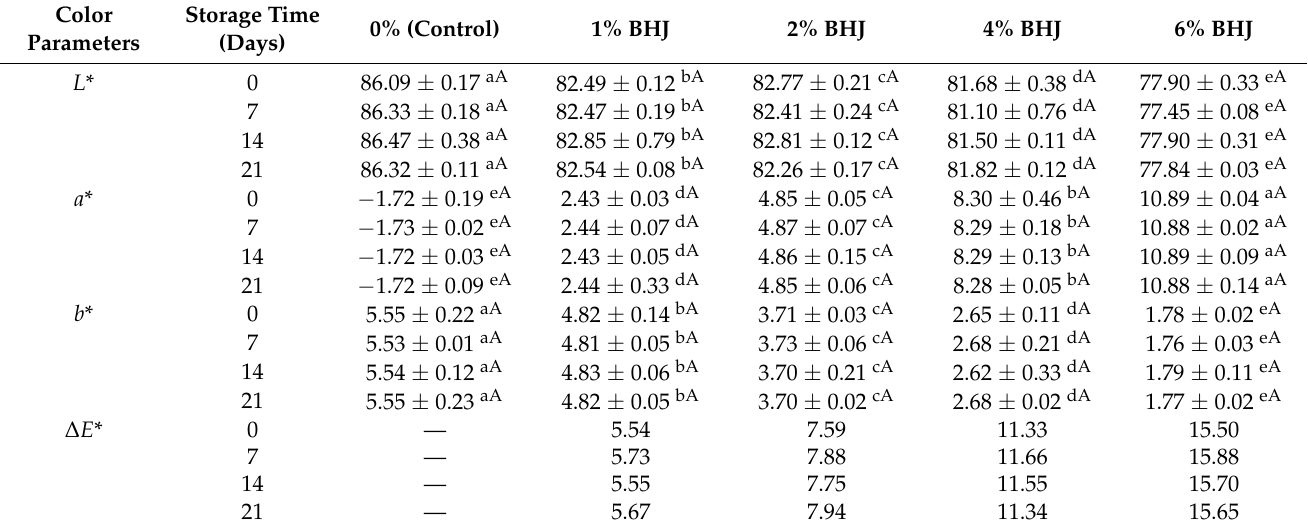
Table 1. Color parameters of FGM supplemented with BHJ during refrigerated